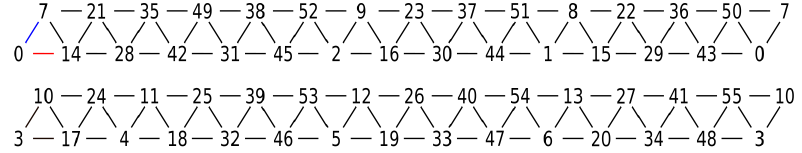
Figure 6: Observable transitions for key bits in register C (top) and D